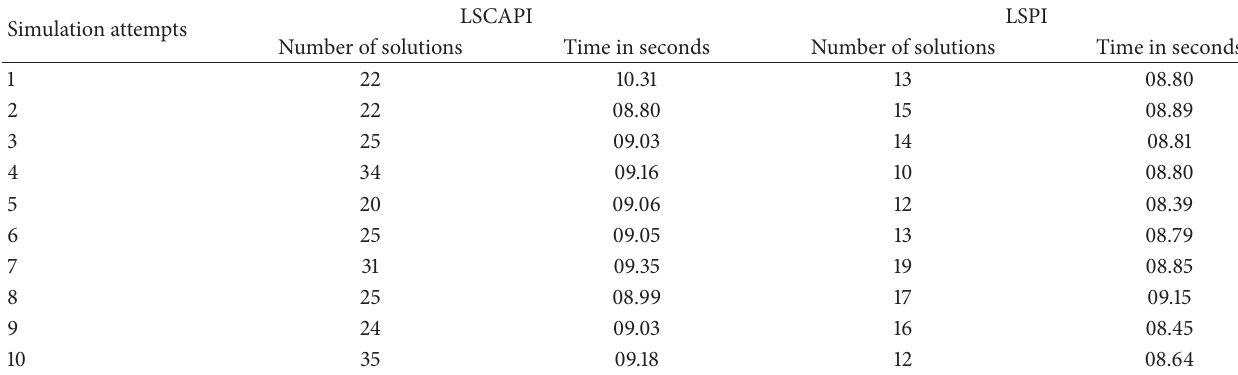
Table 8: Number of solutions and their time generated by LSCAPI versus LSPI.